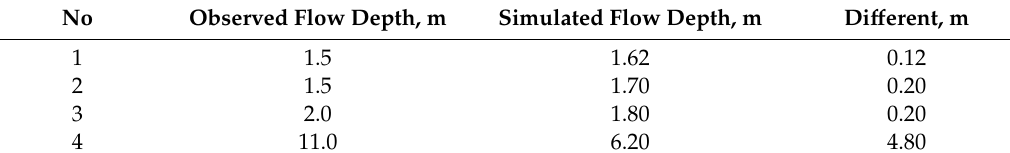
Table 3. Comparison between observation data and simulation results.